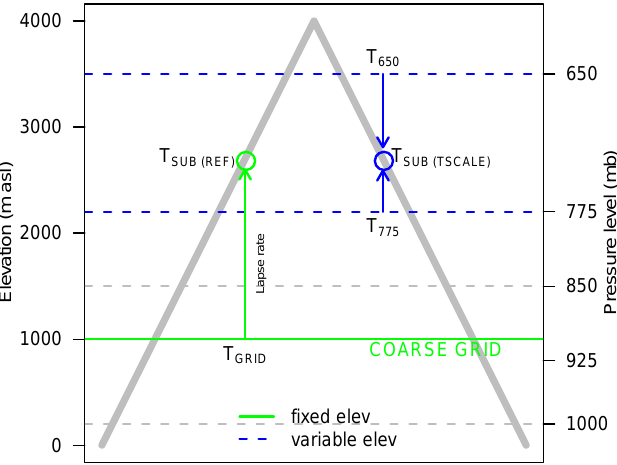
Fig. 2. Schematic of the main TopoSCALE method and experi- ment set up. Green line represents the coarse-grid climate data, and its position in terms of elevation and pressure levels is indicated with respect to topography (grey). Methods for describing a SUB simulation point used in this study: (a) grid level data ( T GRID ), (b) extrapolated grid data by reference methods ( T SUB(REF) ) and (c) TopoSCALE interpolated pressure-level data ( T SUB(TSCALE)